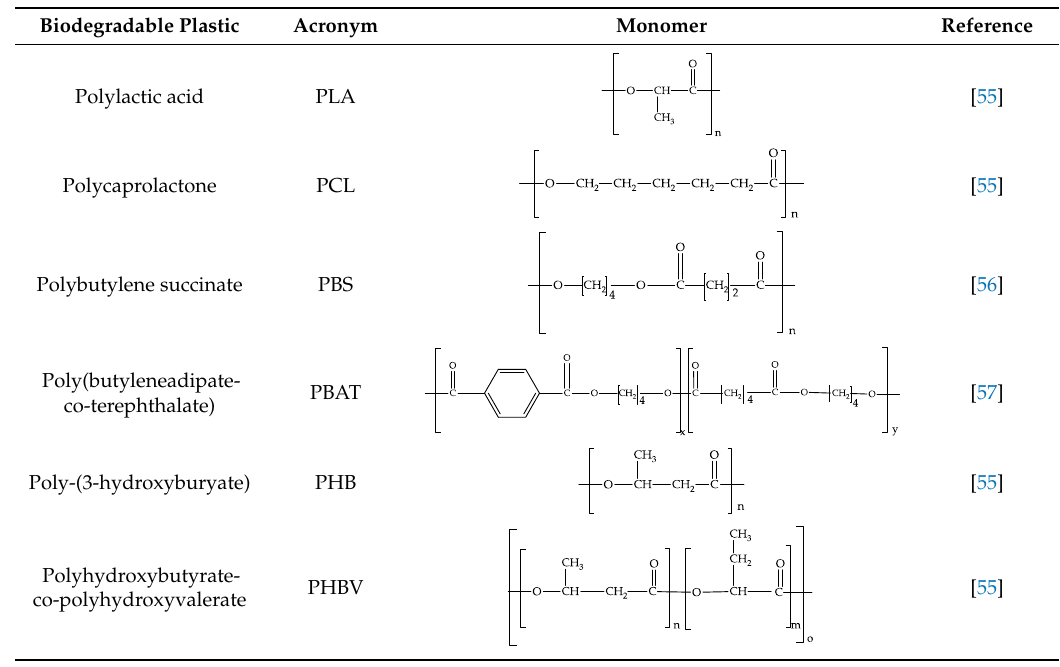
Table 1. Common monomers in biodegradable plastics.